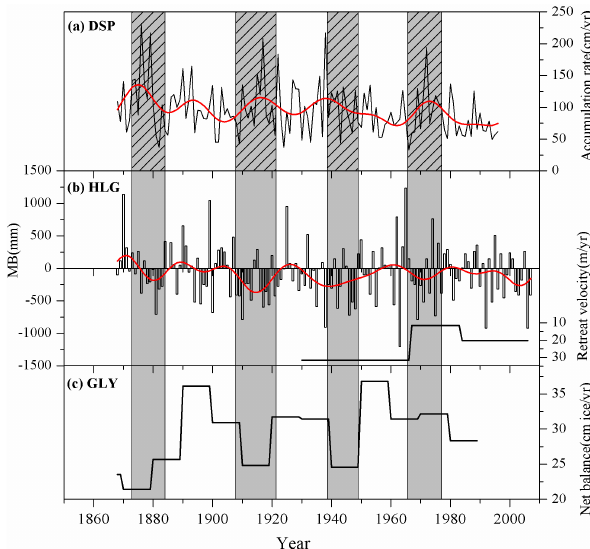
Fig. 5. Comparison of the MB reconstructed in this study (b) with the accumulation rate (annual net balance) recorded in the Dasuopu ice core (Thompson et al., 2000) (a) , the mean frontal retreat ve- locity of the Hailuogou Glacier (Li et al., 2010) (b) , and the decadal average of net balance reconstructed by the Guliya ice core (Thomp- son et al., 1997) (c) . Red lines denote 10yr FFT (fast Fourier trans- form)